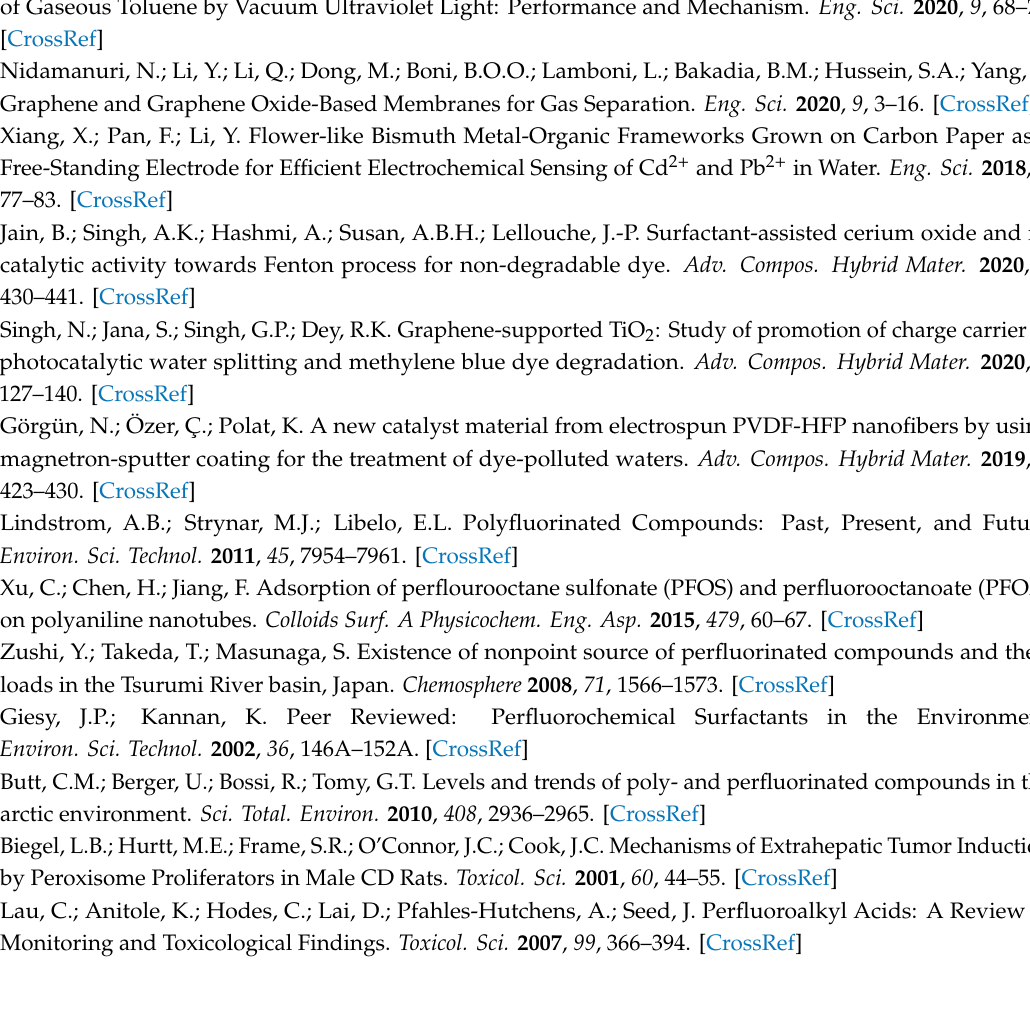
Figure S1: Results of the long-term stability of PANI electrodes on paper ( n =